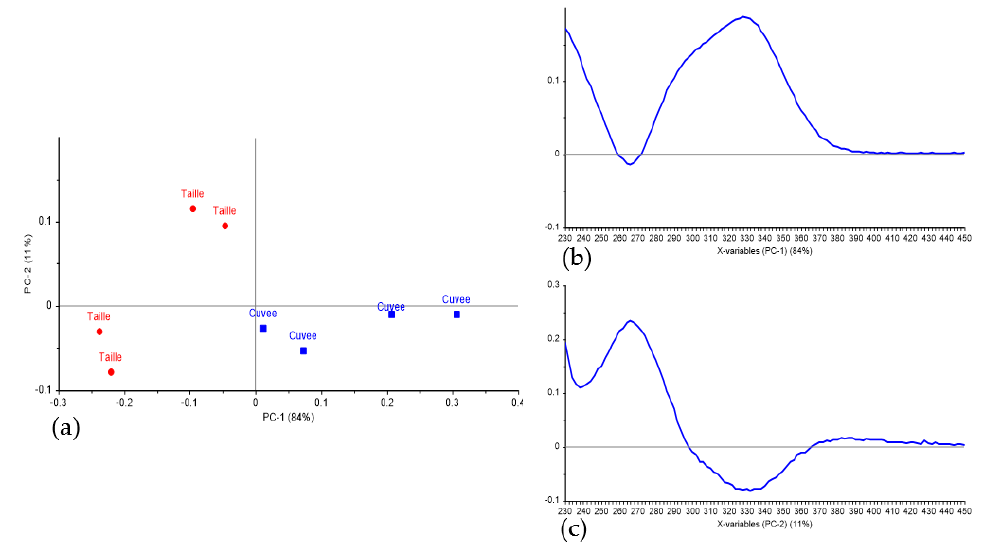
Figure 3. PCA scores and loadings plots of 2011 Pinot noir juice samples from the laboratory scale trial discriminating cuvée from taille . Scores plots ( a ); PC 1 ( b ) and PC 2 ( c ) loadings.